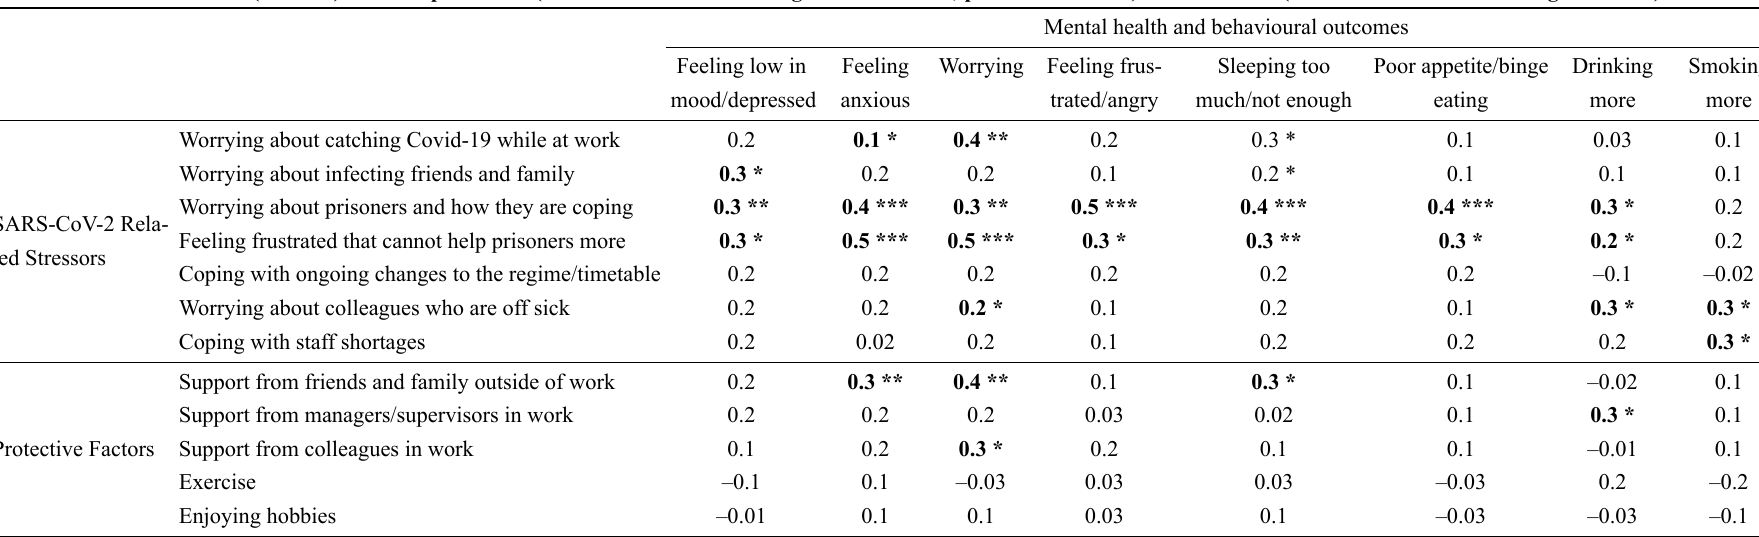
Table 9. Correlations ( r values) between predictors (SARS-CoV-2 related changes and stressors; protective factors) and outcomes (mental health and wellbeing outcomes).